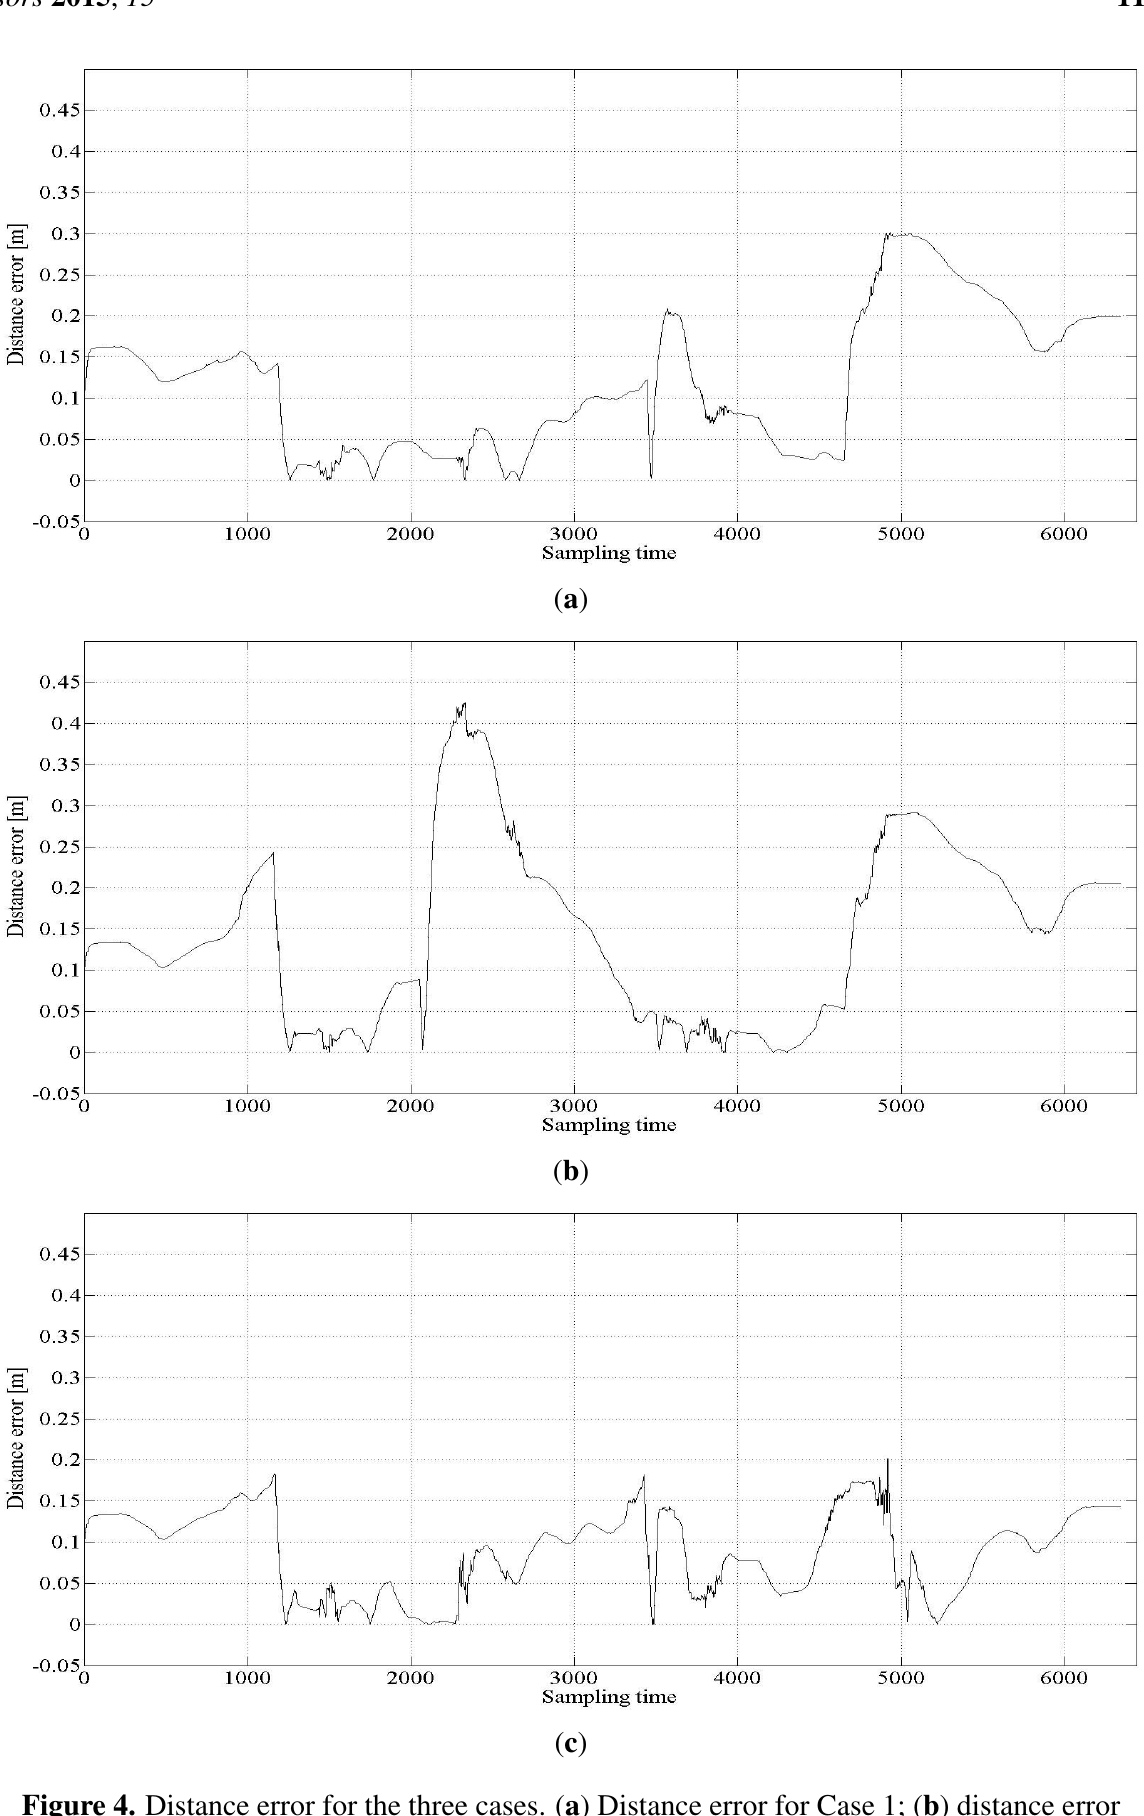
Figure 4. Distance error for the three cases. ( a ) Distance error for Case 1; ( b ) distance error for Case 2; ( c ) distance error for Case